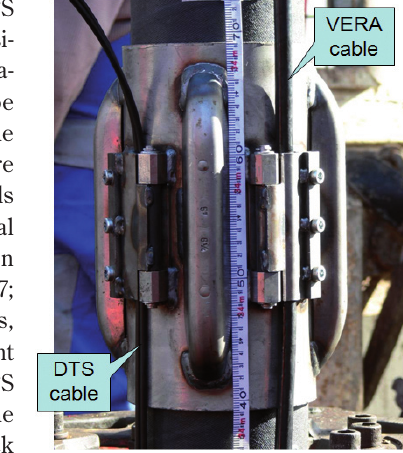
Figure 5. Centralizer attached to casing string with DTS (left) and VERA cables